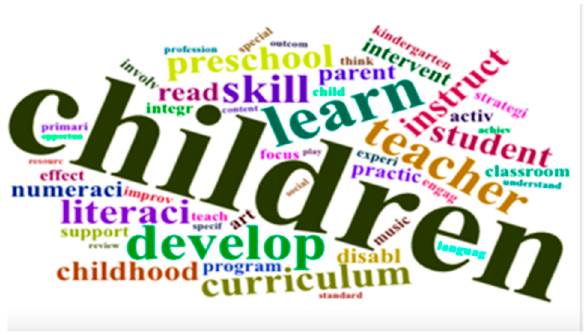
Figure 4. Word cloud of early childhood mathematics education.